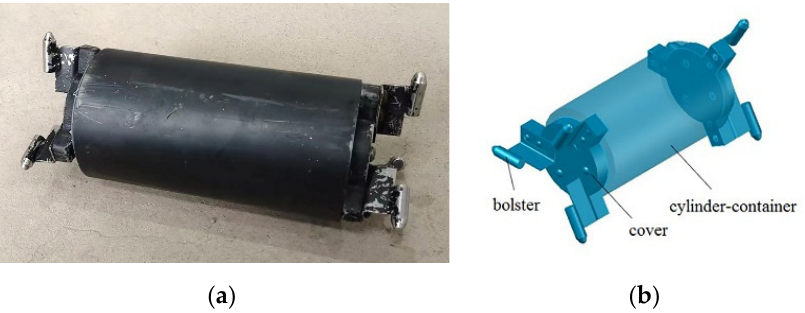
Figure 1. Schematic diagram of the physical model of wheeled capsule: ( a ) physical diagram; ( b ) schematic diagram.